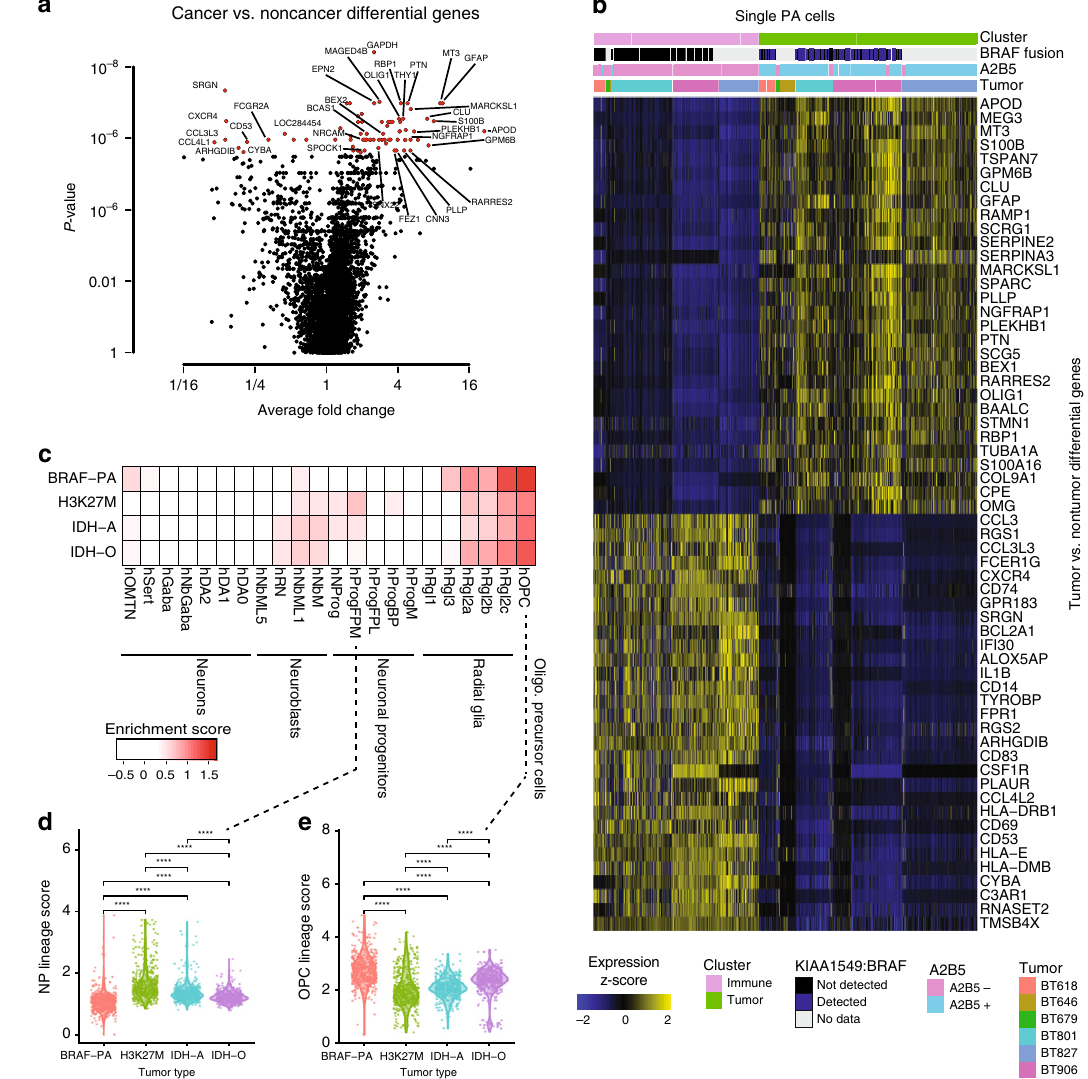
Fig. 4 Genes and normal brain gene sets expressed by PA cancer cells. a Volcano plot showing differentially expressed genes between tumor and non- tumor clusters. P -values are Wilcoxon rank sum test P -values. Genes in red are FDR < 0.05 with Bonferroni correction. b Heat map showing expression z -scores for top differentially expressed genes between cancer cells and tumor-associated cells ( n = 931) in PA. c Heat map showing mean enrichment scores for normal developing midbrain gene signatures 30 for single cells from PA (BRAF-PA), H3K27M-mutated pediatric high-grade midline gliomas 4 (H3K27M), IDH-mutated astrocytomas 3 (IDH-A), and adult IDH-mutated oligodendrogliomas 2 (IDH-O). OMTN oculomotor and trochlear nucleus, Sert serotonergic, NbM medial neuroblast, NbDA neuroblast dopaminergic, DA0-2 dopaminergic neurons, RN red nucleus, Gaba1-2 GABAergic neurons, mNbL1-2 lateral neuroblasts, NbML1-5 mediolateral neuroblasts, NProg neuronal progenitor, Prog progenitor medial fl oorplate (FPM), lateral fl oorplate (FPL), midline (M), basal plate (BP); Rgl1-3 radial glia-like cells, Mgl microglia, Endo endothelial cells, Peric pericytes, Epend ependymal, OPC oligodendrocyte precursor cells. d Violin plot showing ProgFPM lineage scores for cancer cells of each tumor type. e Violin plot showing OPC lineage scores for cancer cells of each tumor type. **** P < 0.0001 (Wilcoxon rank sum